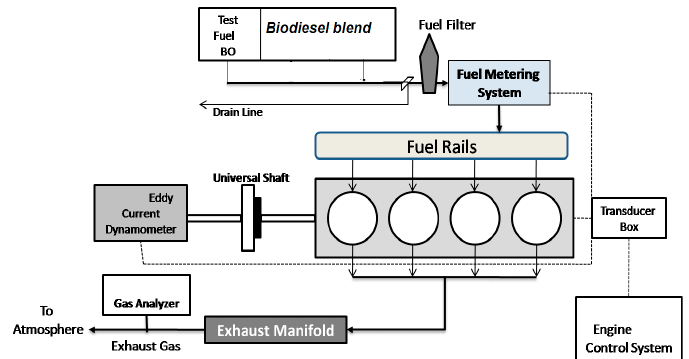
Figure 3. Schematic diagram of the engine test bed. Table 2. The specifications of the engine used in this study.